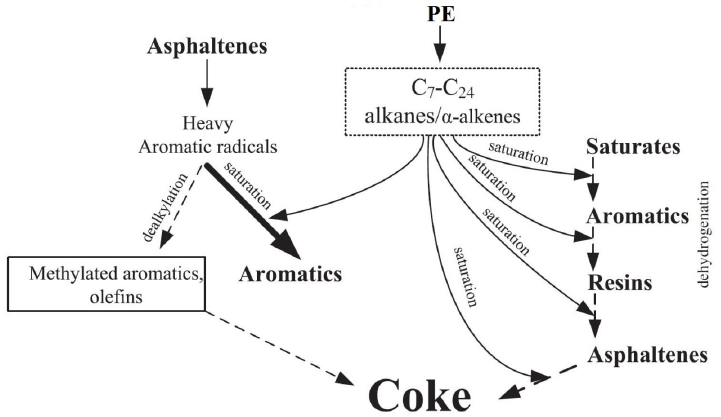
Figure 2. Proposed suppression mechanism of coke in co-pyrolysis of heavy oil and PE. Reproduced with permission from [34], published by Elsevier Limited,